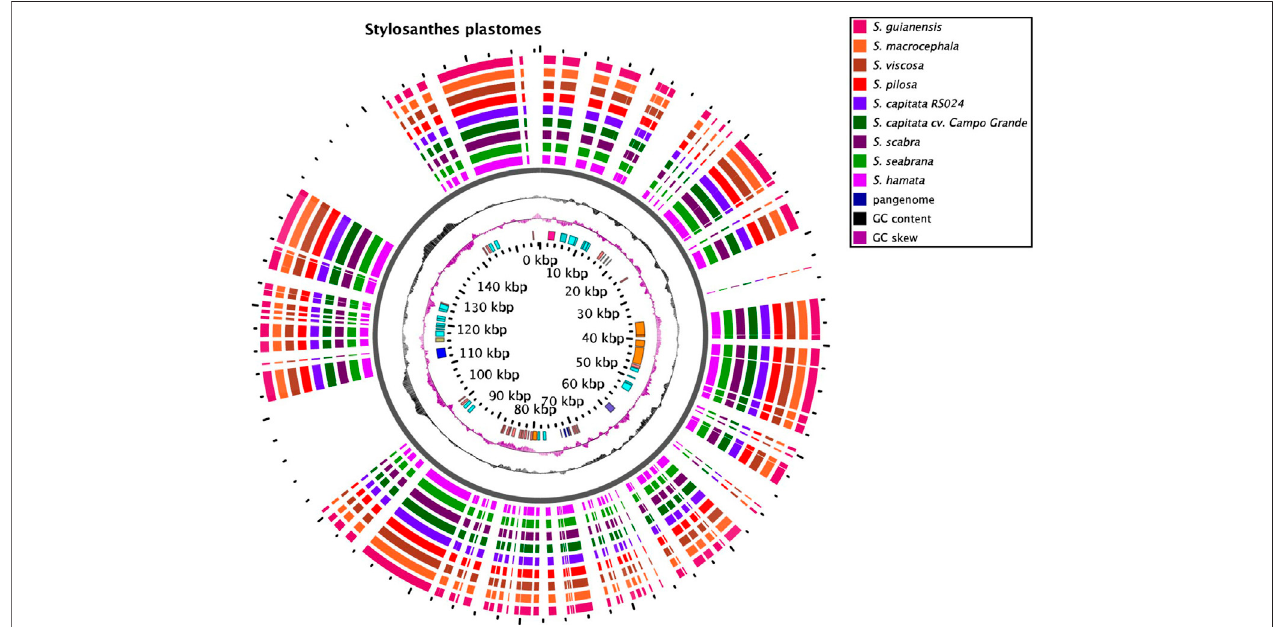
FIGURE 3 | Plastome features of Stylosanthes. Annotated sequences are shown in the inner circle.